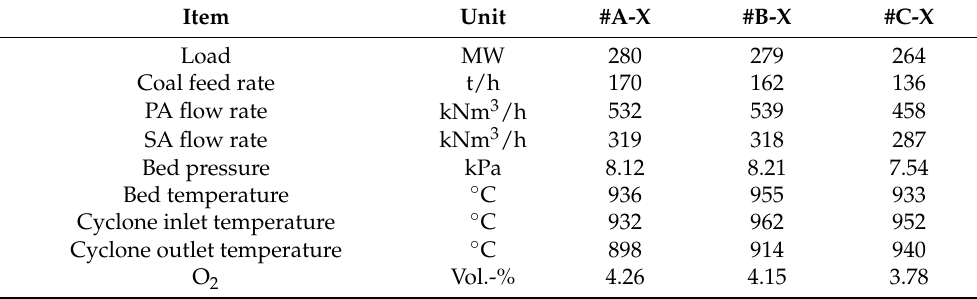
Table 4. Main operating parameters of the boiler during the tests of the horizontal measurement ports at SNCR inlets (X-horizontal direction).